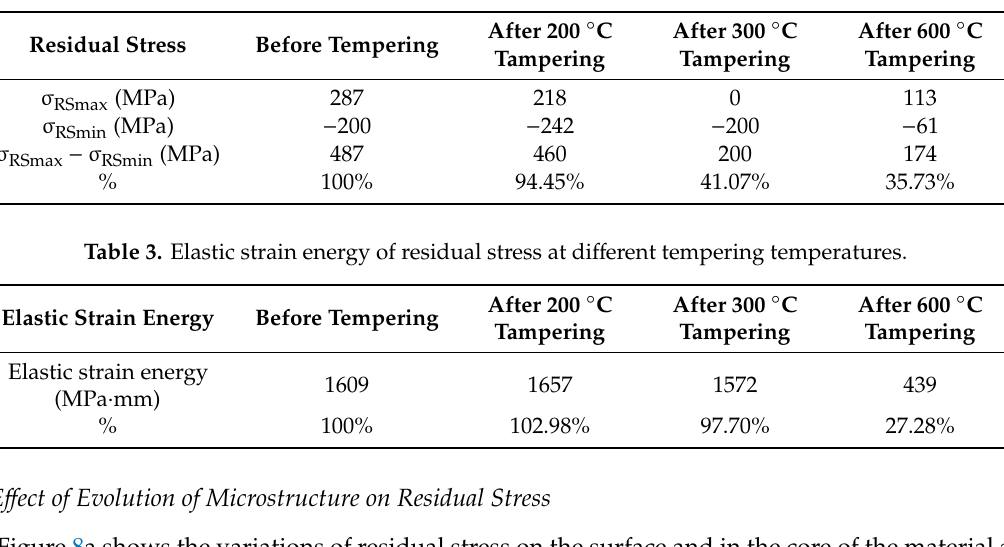
Table 2. Residual stress in 700L at di ff erent tempering temperatures.